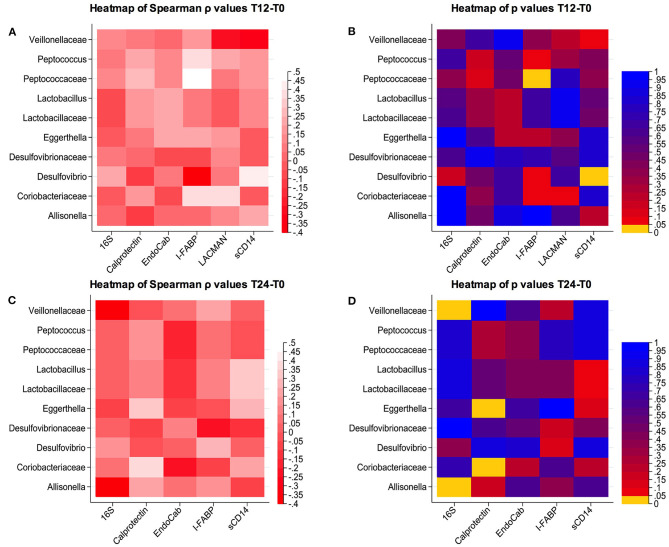
Correlations between changes in microbial composition and soluble biomarkers. (A,B) Spearman correlation and p-values at T12-T0; (C,D) Spearman correlation and p-values at T24-T0.